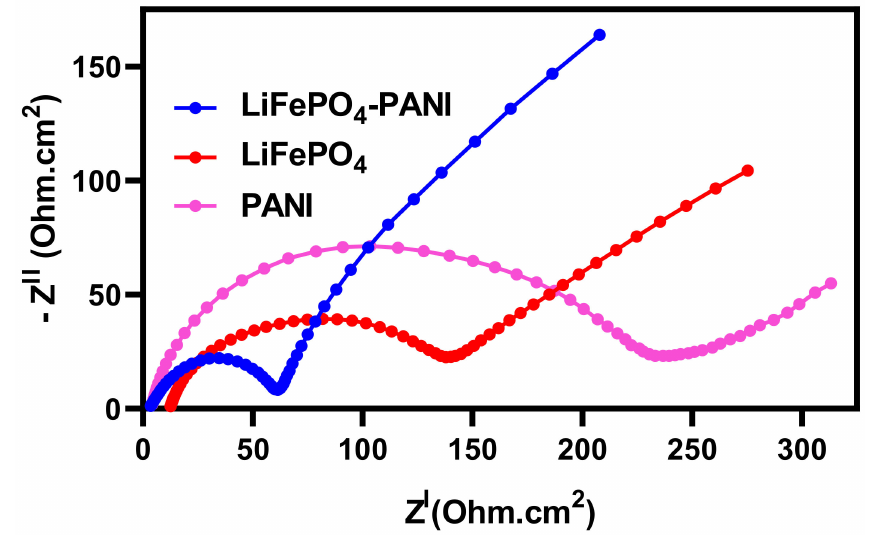
Figure 19. Experimental Nyquist curves for PANI, LiFePO 4 and LiFePO 4